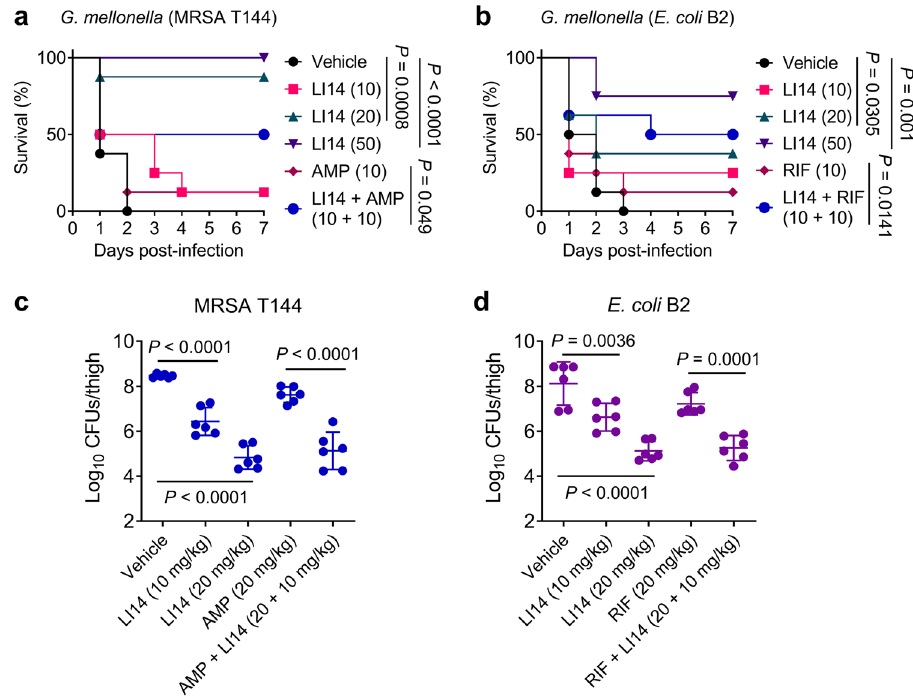
Fig. 6 Therapeutic potential of LI14 peptide in animal models of infection. a , b LI14 alone or in combination with ampicillin (AMP)/rifampicin (RIF) improved the survival of G. mellonella infected with MRSA T144 ( a ) or E. coli B2 ( b ). G. mellonella ( n = 8 biologically independent animals per group) were fi rst infected by two test strains, respectively, and then treated with different concentrations of LI14 peptide or their combination at 1 h after infection. Survival rate of larvae was monitored during 7 days. P values were calculated using log-rank (Mantel-Cox) test. c , d LI14 peptide alone or in combination with ampicillin/rifampicin reduced bacterial burden in a neutropenic mouse thigh infection model. Neutropenic CD-1 mice ( n = 6 biologically independent animals per group) were administered a non-lethal dosage of MRSA T144 ( c ) or E. coli B2 ( d , 10 5 CFUs) intramuscularly, and then treated with a standard injection of LI14 peptide (10 or 20 mg/kg), ampicillin or rifampicin (20 mg/kg), or their combination at 1 h after nfection. The amount of bacteria load in the thighs of mice after 48 h treatment was determined. The Mann – Whitney U-test was used to evaluate the P values for the data, which were given as mean ±